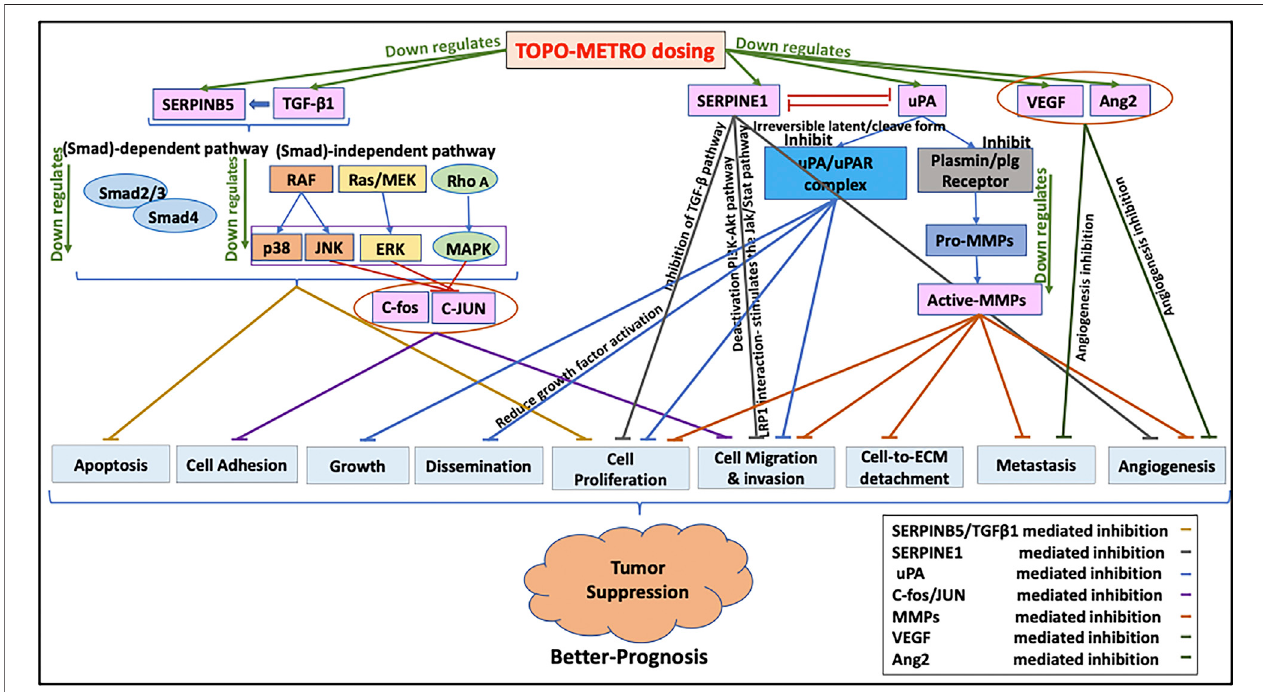
FIGURE 8 | Proposed mechanisms underlying increased potency of METRO-TOPO dosing. METRO-TOPO treatment downregulates the key cancer pathway genes, which are responsible for cell proliferation, migration, invasion, differentiation, transformation, metastasis, and anti-angiogenesis.